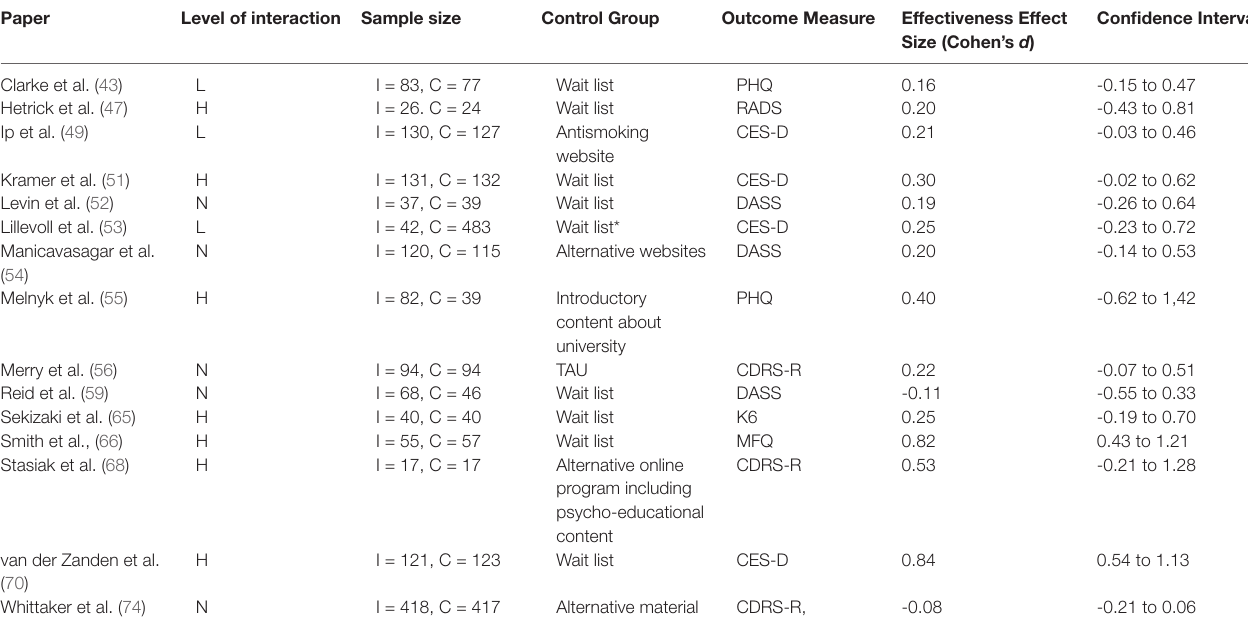
TABLE 3 | RCTs included in